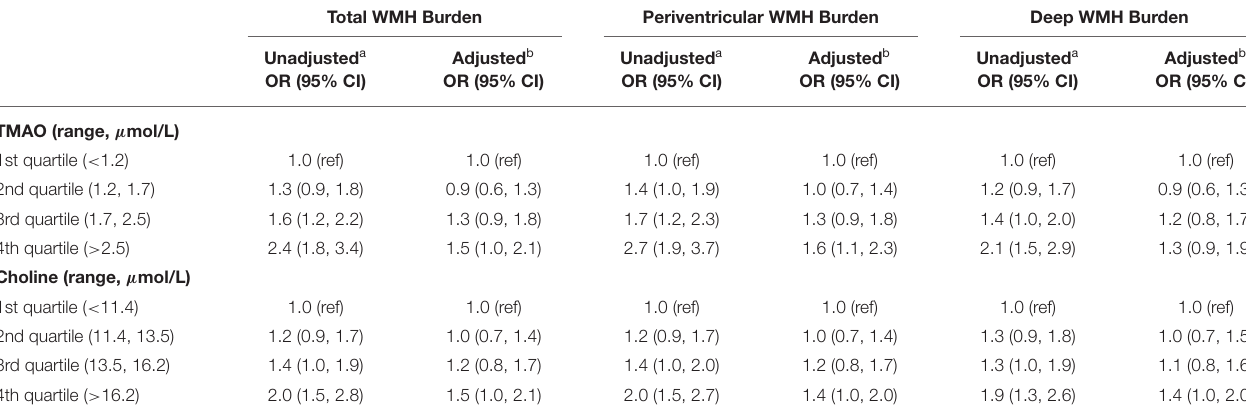
Total WMH Burden Periventricular WMH Burden Deep WMH Burden Unadjusted a Adjusted b Unadjusted a Adjusted b Unadjusted a Adjusted b OR (95% CI) OR (95% CI) OR (95% CI) OR (95% CI) OR (95% CI) OR (95% CI)